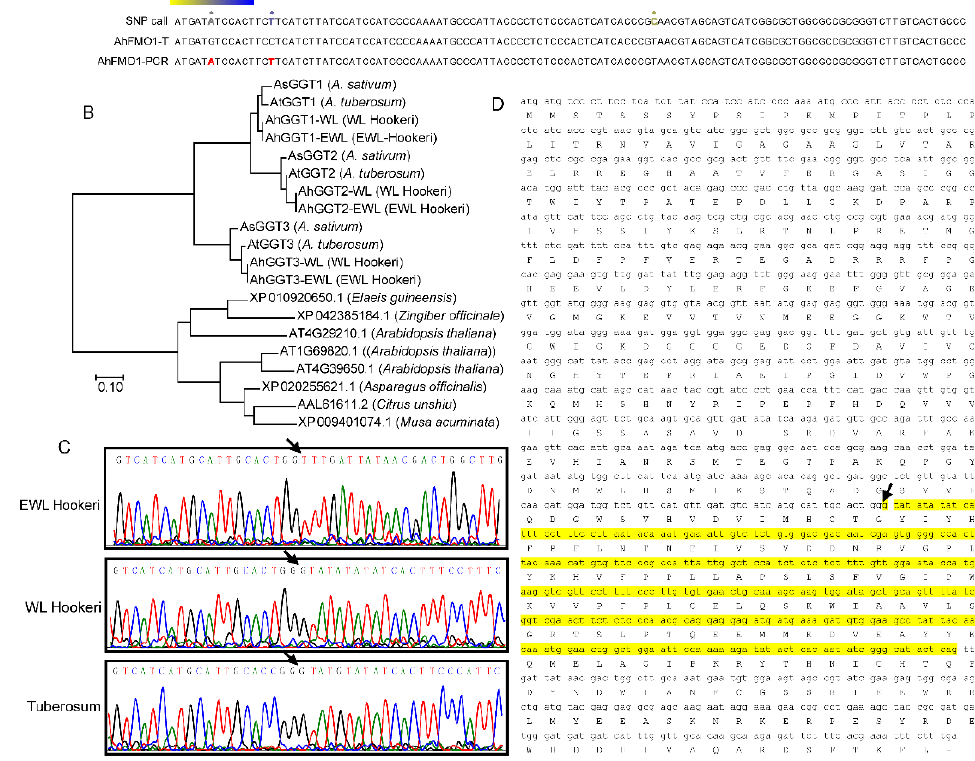
Figure 5. Gene sequential analysis of GGTs and FMO1 . ( A ) A partial illustration of SNP calls that were obtained by mapping RNA-seq reads back to an assembled AhFMO1-WL transcript ( AhFMO1-T ). The ratio of SNP was calculated using RNA-seq reads. ( B ) Phylogenetic analysis of GGTs gene. ( C , D ) FMO1 in EWL Hookeri lost a 310-bp CDS region (denoted in yellow color) which led to a frameshift and large deletion. The arrow indicates the start point of the frameshift.